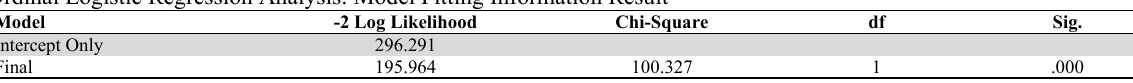
Ordinal Logistic Regression Analysis: Model Fitting Information Result Model -2 Log Likelihood